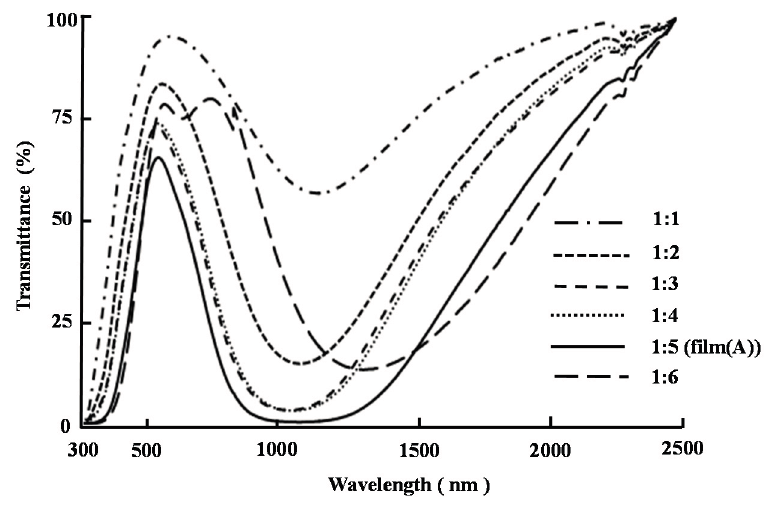
Figure 6. UV-visible-NIR transmittance spectra of films with the molar ratio of compounds 4 and 5 = 1:1, 1:2, 1:3, 1:4, 1:5, and 1:6 after heating treatment at 200 °C for 3 min.